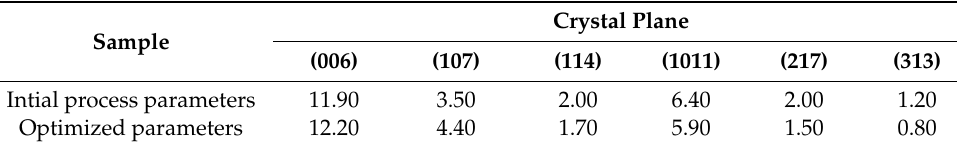
Table 9. Texture coefficient (TC).